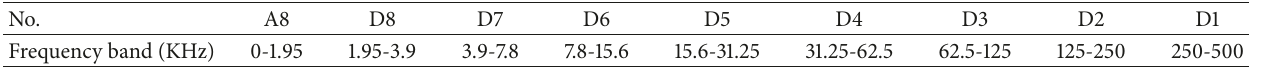
Figure 13: (a) (upper) Block diagram of the 4 levels of wavelet packet decompositions for vibration signal; (b) (lower) front panel of the time-frequency analysis. Table 6: Frequency bands of AE signal after eight levels of multiresolution